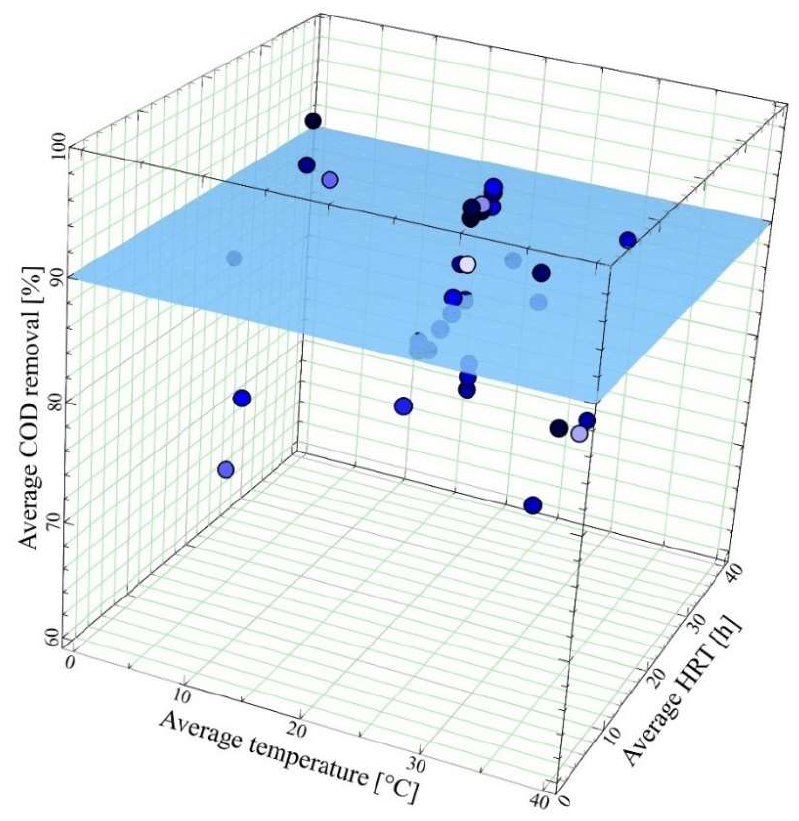
Figure 7. The impact of average temperature and HRT on the average COD removal during treatment of real and synthetic domestic wastewaters in